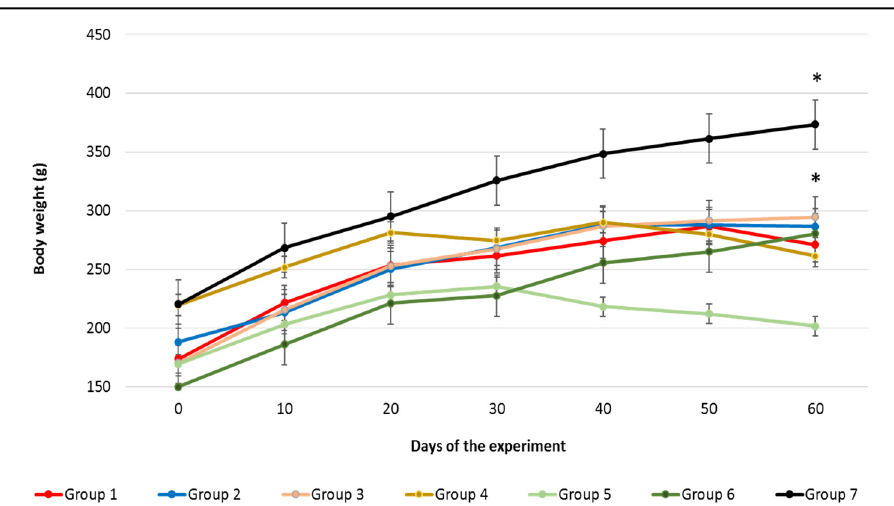
Figure 1. The effect of carvacrol and MNNG application on the body weight of Wistar rats during the experiment. Standard deviations (SDs) are given as mean ± SD. * Values are significantly differed between their initial and final BW at p ≤ 0.001.